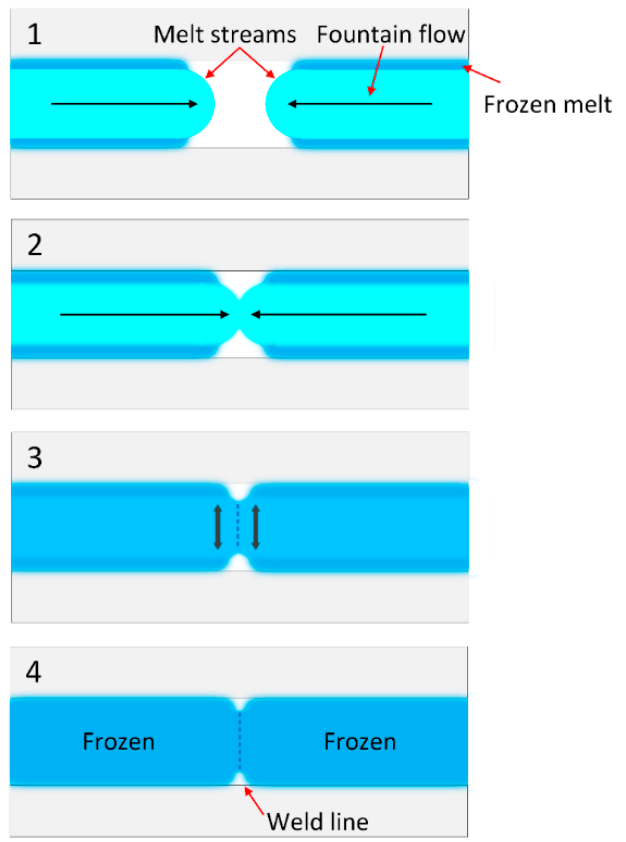
Figure 1. The weld line appearance in the injection molded part. Polymer materials may suffer severe damage due to the fatigue phenomenon after Polypropylene (PP) is a prevalent polymer material due to its advantages in mechan- being used for an expected period under a moderate load [31–33]. The fatigue properties ical, chemical, and physical properties [13,14]. PP is a lightweight thermoplastic polymer. It also has a high level of chemical resistance. Furthermore, PP can be manufactured using studied [34–36]. For example, Ferreira et al. [37] investigated the fatigue properties of PP various techniques such as injection molding, extrusion, blowing, and compression composites reinforced with glass fiber. This report demonstrated the superiority of the 0 ◦ -angle laminate over 30 ◦ and 45 ◦ angles. Gamstedt et al. [38] added maleic anhydride [15,16]. PP is less expensive and more flexible for thermal forming than other common modification and discovered that it could strengthen the interfacial zone. As a result, it polymers such as polyethylene (PE), polystyrene (PS), polyethylene terephthalate (PET), may improve the fatigue strength of the fiberglass-reinforced PP and polyvinyl chloride (PVC) [17–20]. Other uses include fan blades, hand tools, bicycle